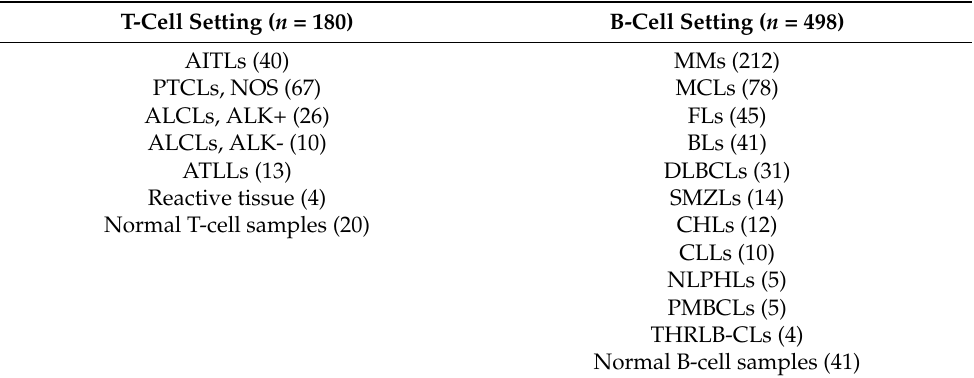
Table 2. Samples, comprising malignant and non-malignant T- and B-cells, used in GEP analysis. T-Cell Setting ( n = 180)